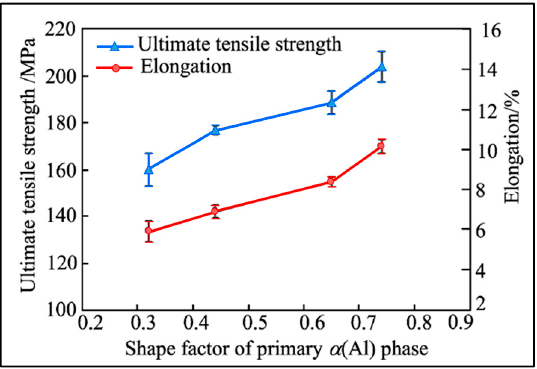
Figure 8. Effect of shape factor of primary α -Al phase on ultimate tensile strength and elongation of semi-solid slurry for Al–Si–Mg–Fe alloy in as-cast condition [68].